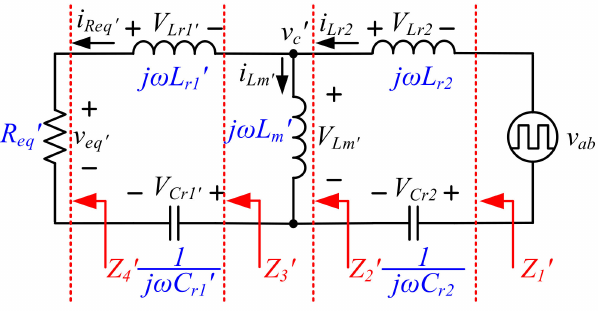
Figure 3. Equivalent circuit diagram of the proposed bidirectional CL 3 C resonant converter in the discharging